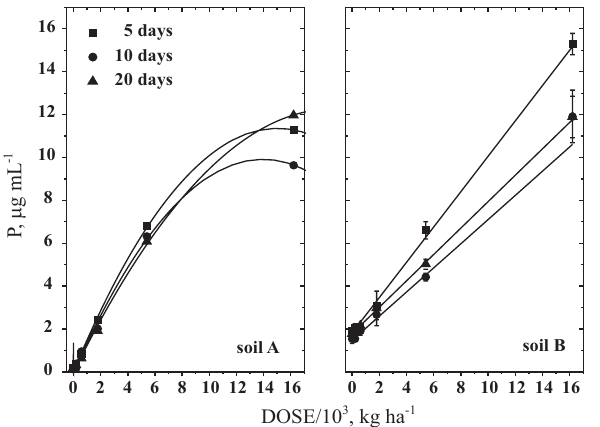
Figure 4. Phosphorous extractability under increasing doses of solid residue in soils A and B. Table 3 shows the fitted parameter values according to the algebraic model adjusted to P